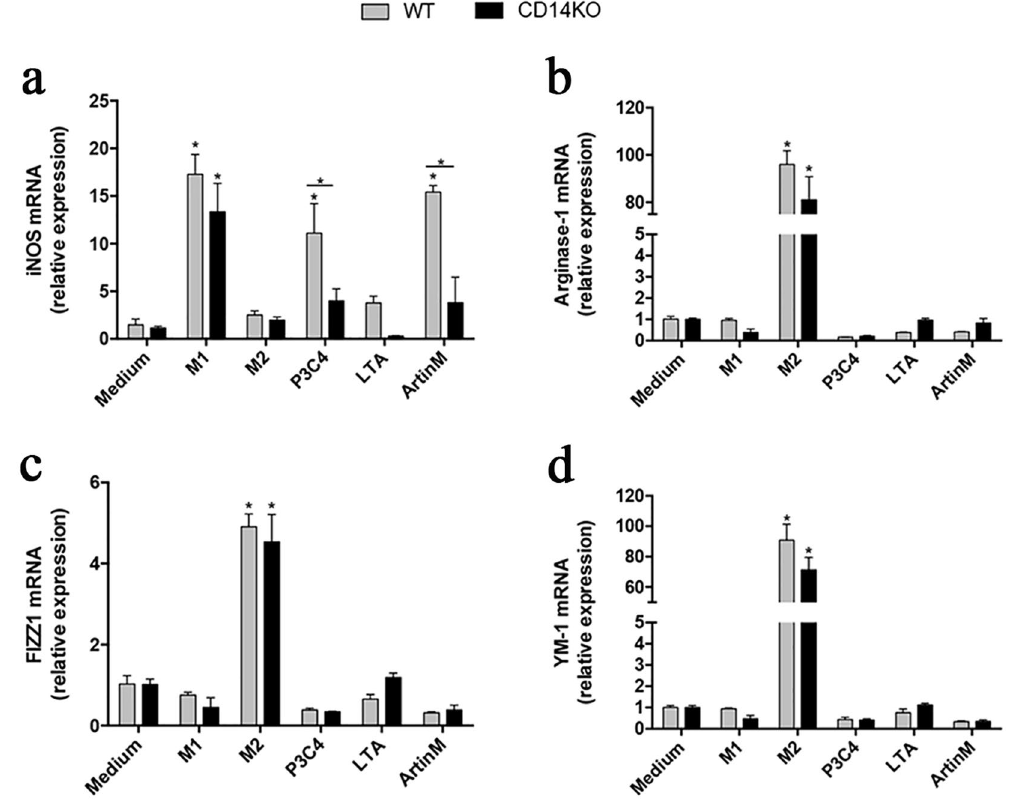
Figure 2. ArtinM activation of macrophages uses CD14 to promote M1 polarization. Macrophages (2 × 10 6 /mL) from the WT and CD14 KO mice were incubated with ArtinM (2.5 µ g/mL), P3C4 (1 µ g/mL), LTA (1 µ g/mL), IFN- γ (M1; 50 ng/mL), IL-4 plus IL-10 (M2; 50 ng/mL), or medium for 10 h. The RNA samples extracted from these cells were reverse-transcribed into cDNA and analyzed for the expression of iNOS2, Fizz1, Arginase-1, and YM-1 by real-time polymerase chain reaction (PCR). The relative expression levels in WT and CD14 KO macrophages stimulated with M1, M2, P3C4, LTA, and ArtinM were compared with those of cells in medium, and the expression levels were also compared between WT and CD14 KO macrophages under similar conditions. Data are shown as means ± SEM of independent experiments. * p < 0.05, according to one-way analysis of variance and Bonferroni’s